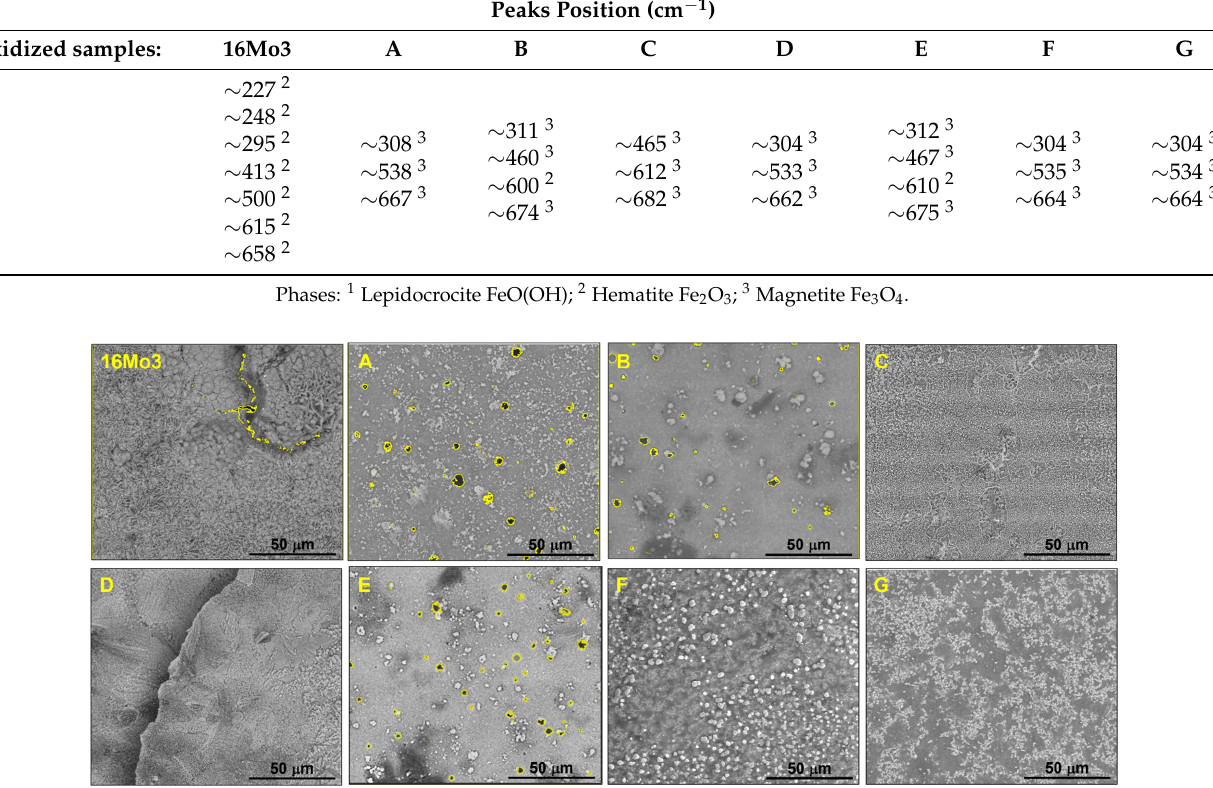
Peaks Position (cm − 1 )